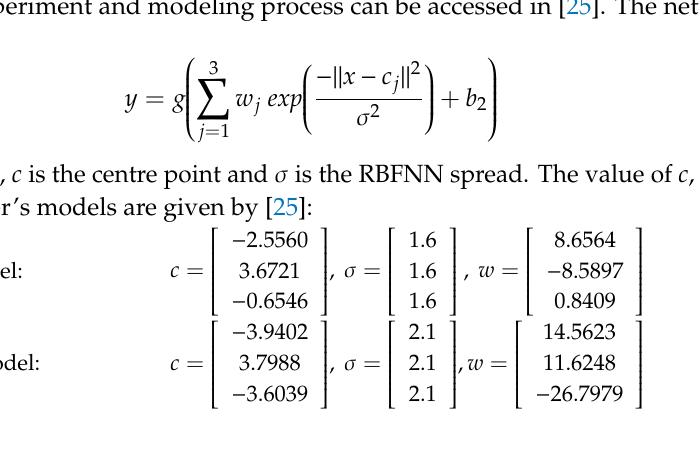
6 of 14 Figure 5. Pre-defined path. 2.4. Radial Basis Function Neural Network (RBFNN) Modeling Figure 6 depicts the structure of the RBFNN. It has a single input layer, a single hidden layer consists of Gaussian radial basis function and a single output layer. The network input, 𝑥 is used as